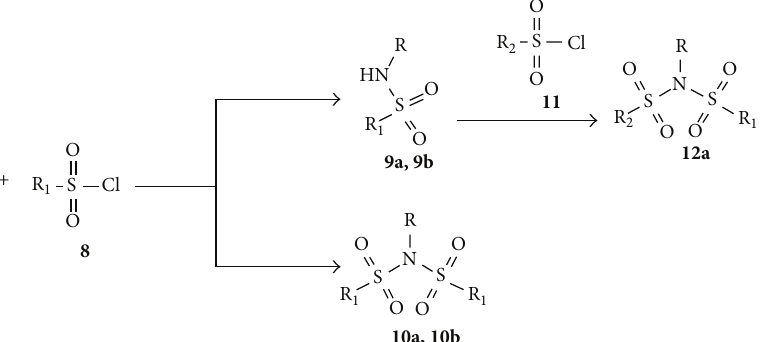
Scheme 2: Benzene sulfonamides (series 1).